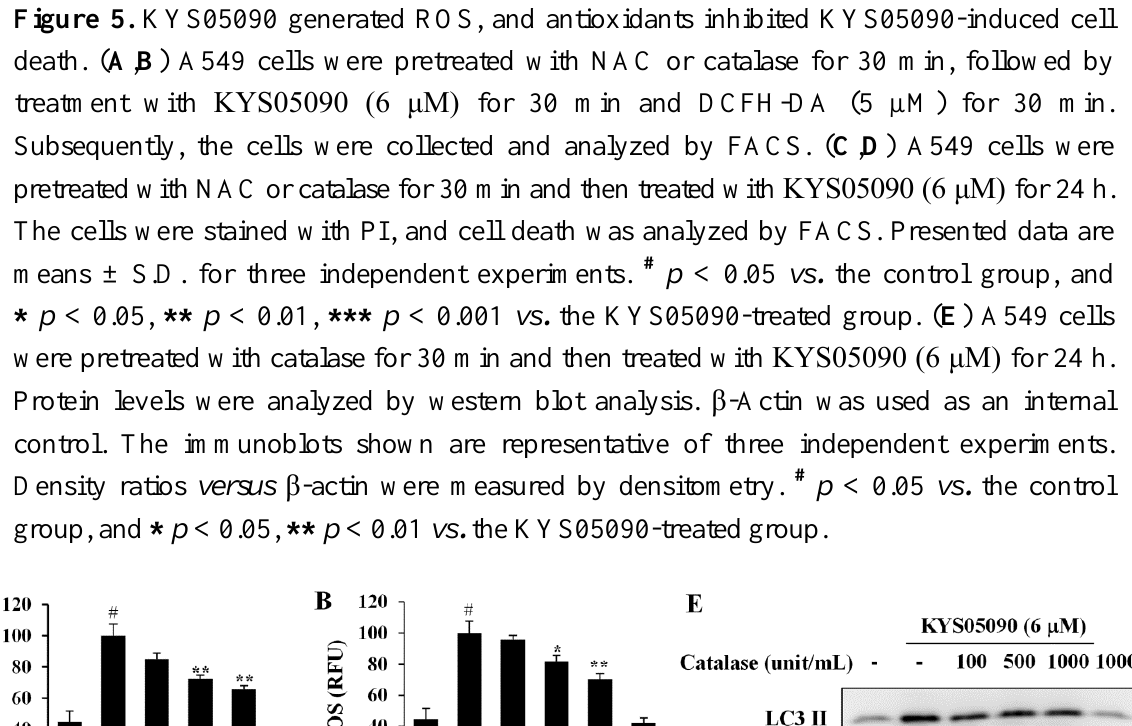
Figure 5. KYS05090 generated ROS, and antioxidants inhibited KYS05090-induced cell death. ( A , B ) A549 cells were pretreated with NAC or catalase for 30 min, followed